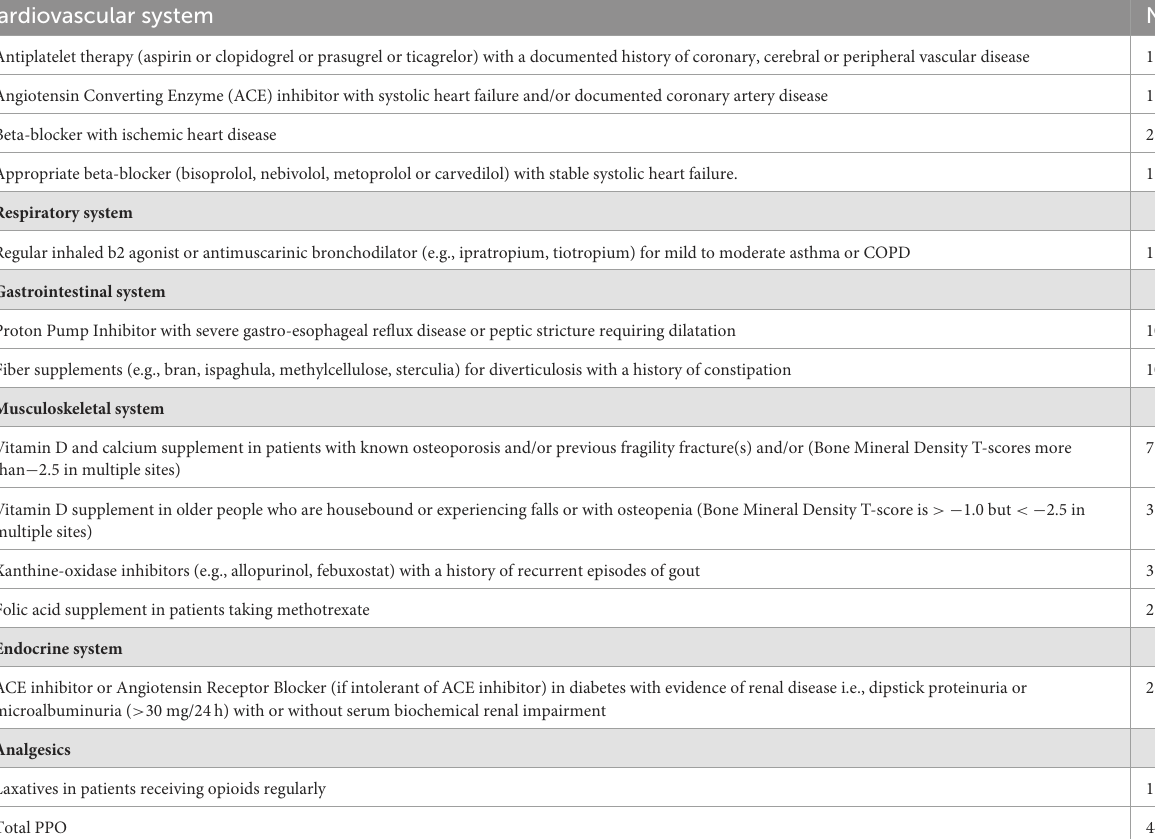
TABLE 5 Screening tool to alert doctors to right i.e., appropriate, indicated treatment (START). Cardiovascular